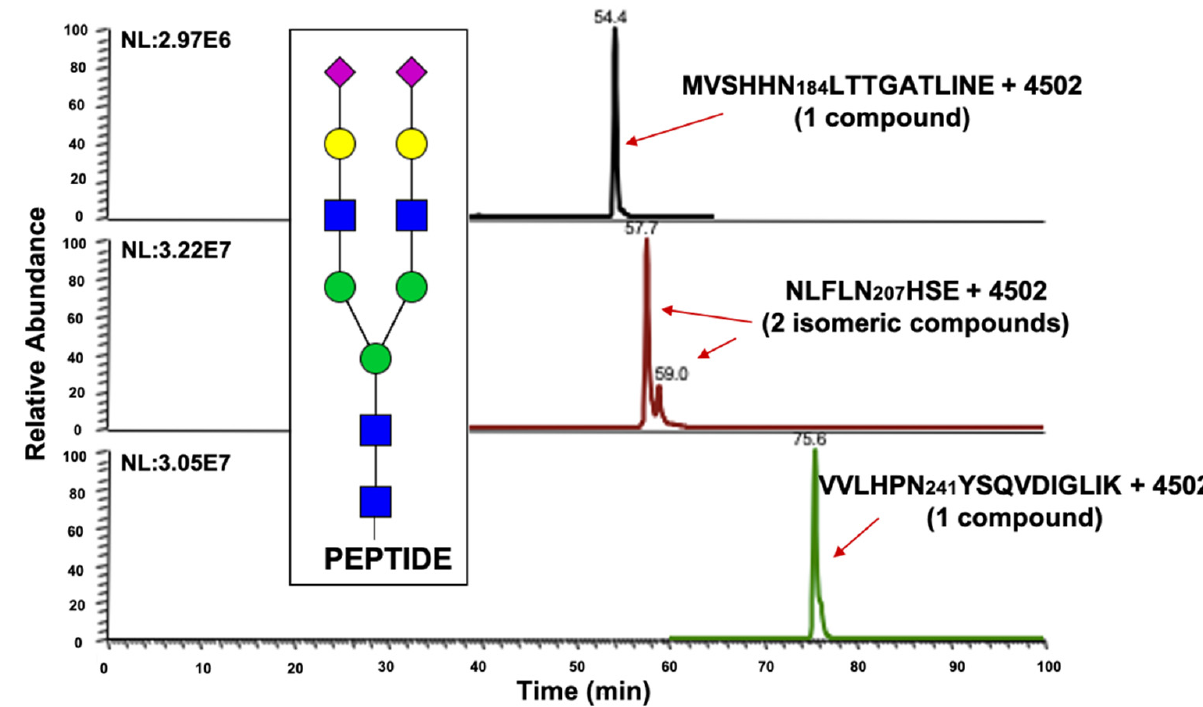
Figure 3. N -glycan distribution among glycosylation sites of the glycan structure HexNAc 4 Hex 5 Neu5Ac 2 (4-5-0-2). Glycan Figure 3. N- glycan distribution among glycosylation sites of the glycan structure nomenclature: HexNAc, Hex, Fuc, NeuAc ( N -acetylhexosamine, hexose, fucose, N -acetylneuraminic acid, HexNAc 4 Hex 5 Neu5Ac 2 (4-5-0-2). Glycan nomenclature: HexNAc, Hex, Fuc, NeuAc ( N- acetylhex- osamine, hexose, fucose, N- acetylneuraminic acid, respectively).